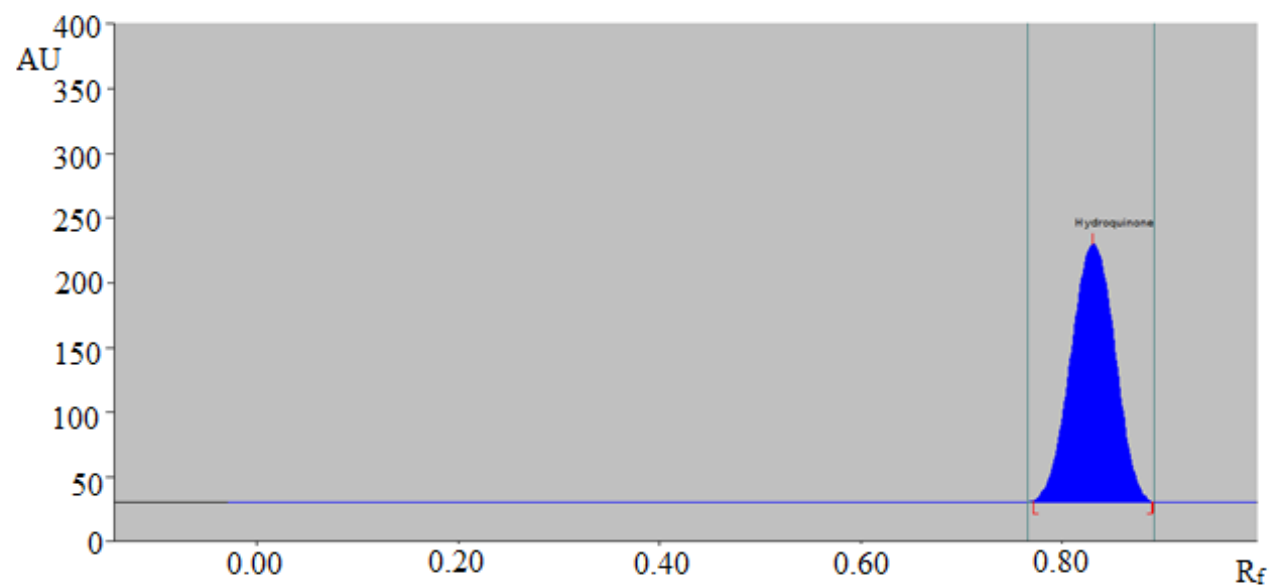
Figure 1. Representative chromatogram of 600 ng band − 1 concentration of standard hydroquinone (HDQ) for the green/ecologically sustainable high-performance thin-layer chromatography (HPTLC) method.